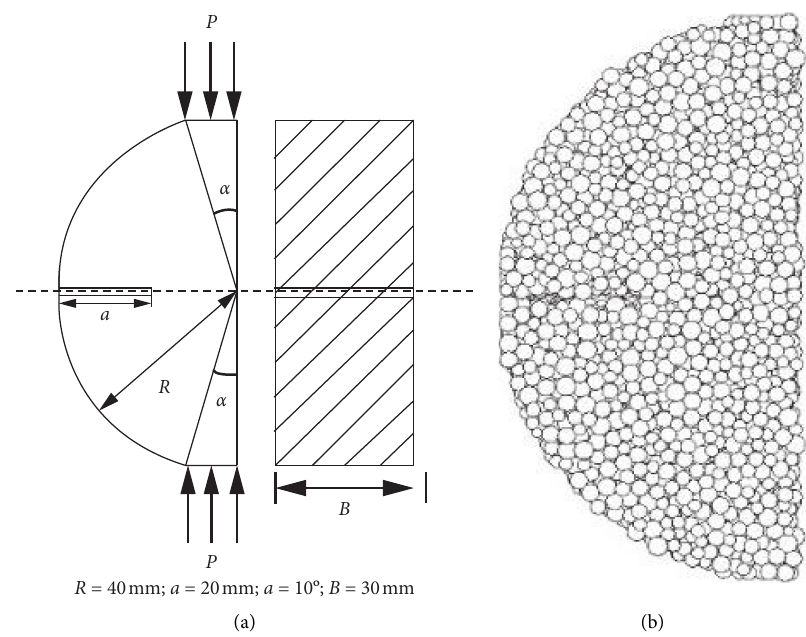
Figure 7: Edge cracked flattened semicircular disc model. (a) Model size. (b) PFC 3D model.